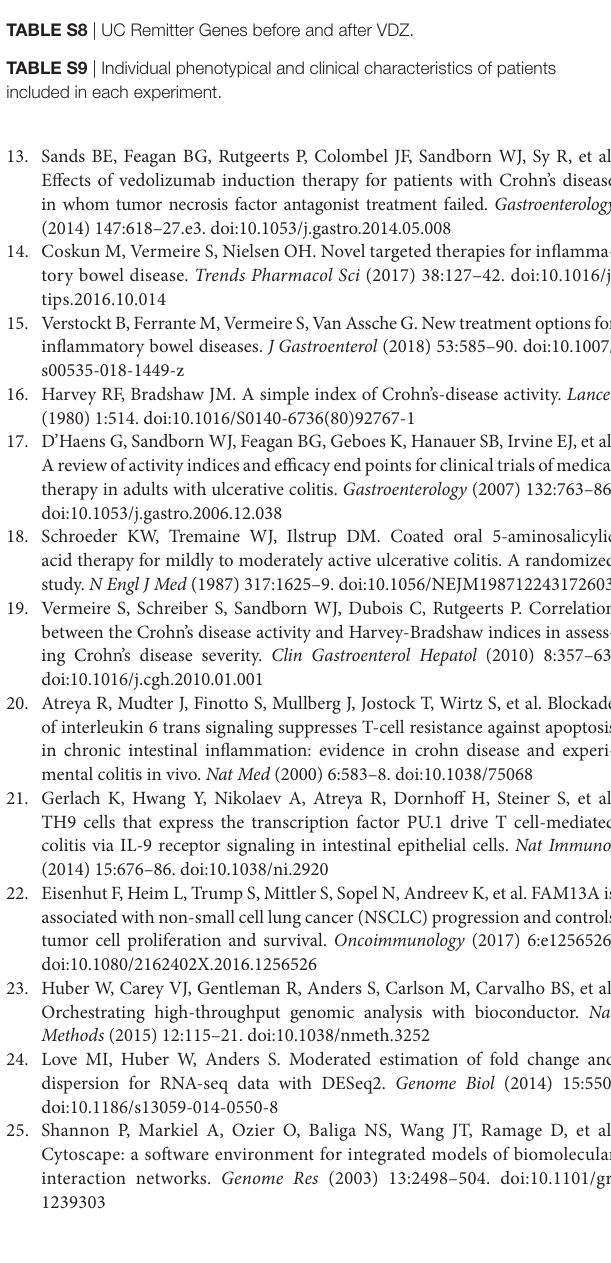
TaBle s1 | CD Genes before and after VDZ. TaBle s2 | CD pathways before and after VDZ. TaBle s3 | CD Non-Remitter Genes before and after VDZ. TaBle s4 | CD Remitter Genes before and after VDZ. TaBle s5 | UC Genes before and after VDZ. TaBle s6 | UC pathways before and after VDZ. TaBle s7 | UC Non-Remitter Genes before and after VDZ. TaBle s8 | UC Remitter Genes before and after VDZ. TaBle s9 | Individual phenotypical and clinical characteristics of patients included in each